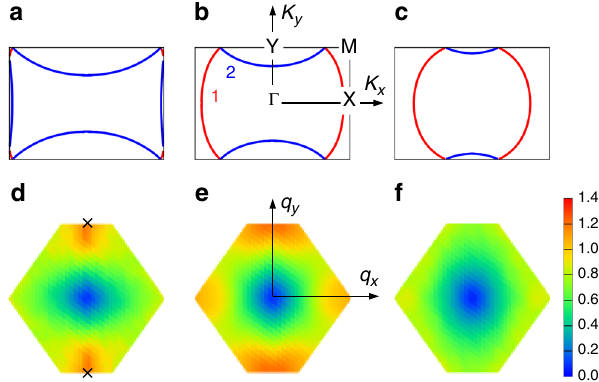
Fig. 3 Fermi surface and spin structure factor. a – c Non-interacting ( U = V ij = 0) FS for ( a ) n = 2/3, ( b ) 1/2, and ( c ) 1/3. Red and blue indicate the hole portions of the FS formed by bands 1 and 2, respectively (See Fig. 1b). High symmetry points are Γ (0,0), M( π / R x , π /2 R y ), X( π / R x ,0), and Y(0, π /2 R y ). d – f Interdimer spin structure factor S dim ( q ) for ( d ) n hole = 2/3 with U = t n = 1/2 with U = t n = 1/3 with U = t b 1 ¼ 4, ( e ) b 1 ¼ 7, and ( f ) b 1 ¼ 6. hole hole Crosses indicate q = (0, ± π / R y ) in d NATURE COMMUNICATIONS| (2019) 10:3167